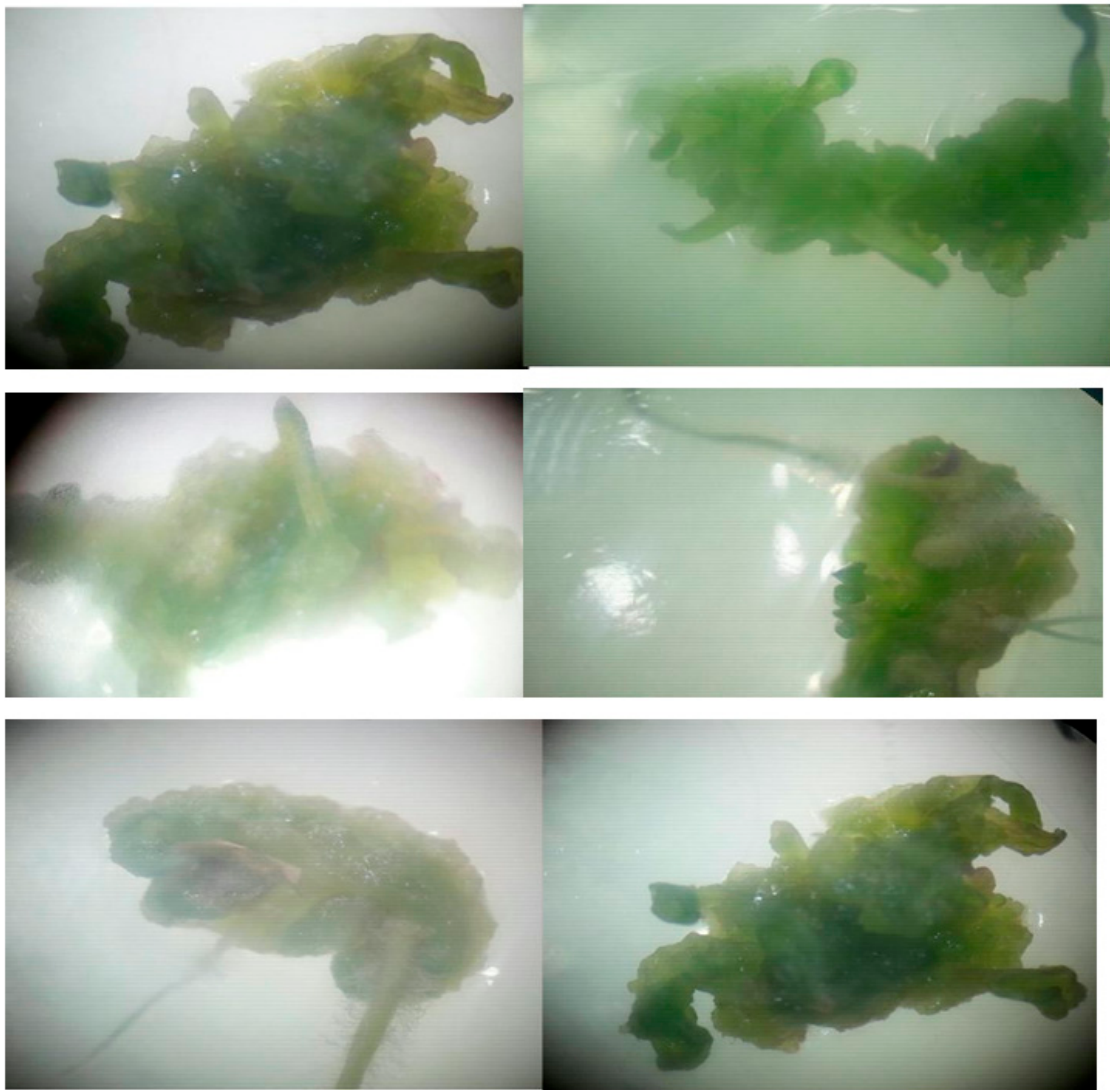
Figure 1. Calli regeneration from explants after two weeks.